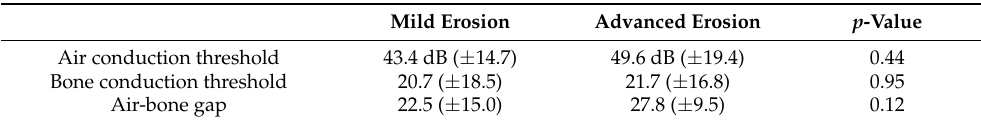
Table 1. The average four-frequency pure tone audiometric thresholds at 0.5, 1, 2, and 4 kHz for fewer cholesteatomas with mild (n = 8) and advanced ossicular erosion (n = 20). The p -values of the Wilcoxon nonparametric test were used to determine statistical significance.